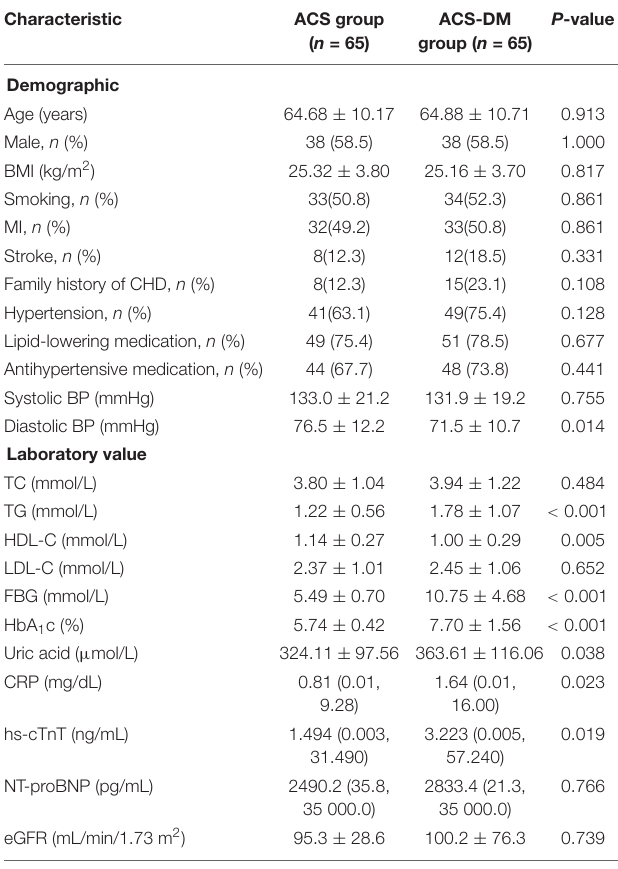
TABLE 1 | Clinical characteristics of the subjects categorized by disease status.